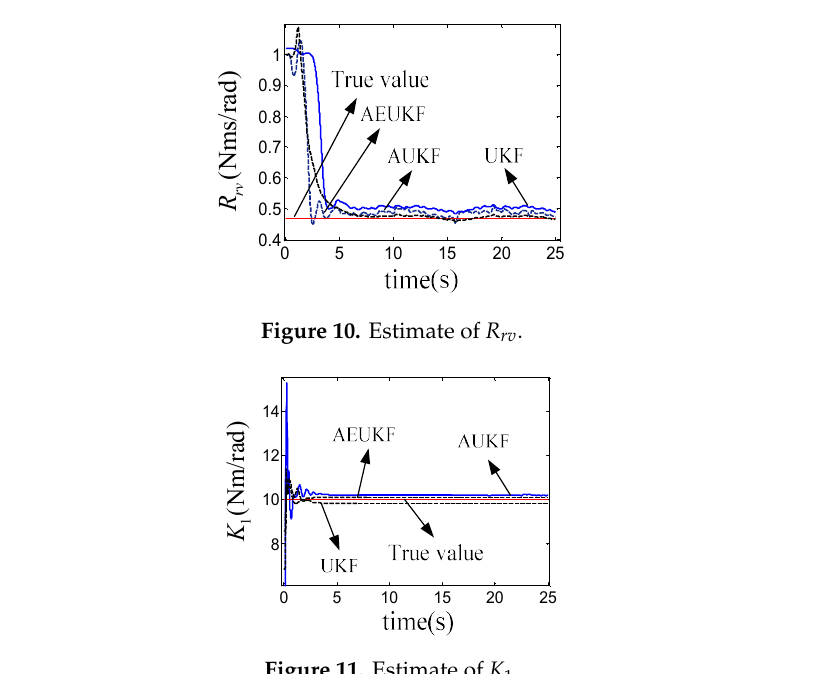
Figure 11. Estimate of K 1 . Table 4. Comparison of fault estimation Table 5. Comparison of remaining useful life (RUL) prediction performance.